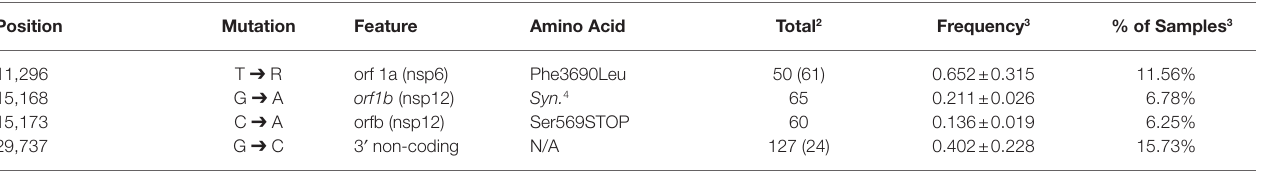
TABLE 4 | Most common minor variants 1